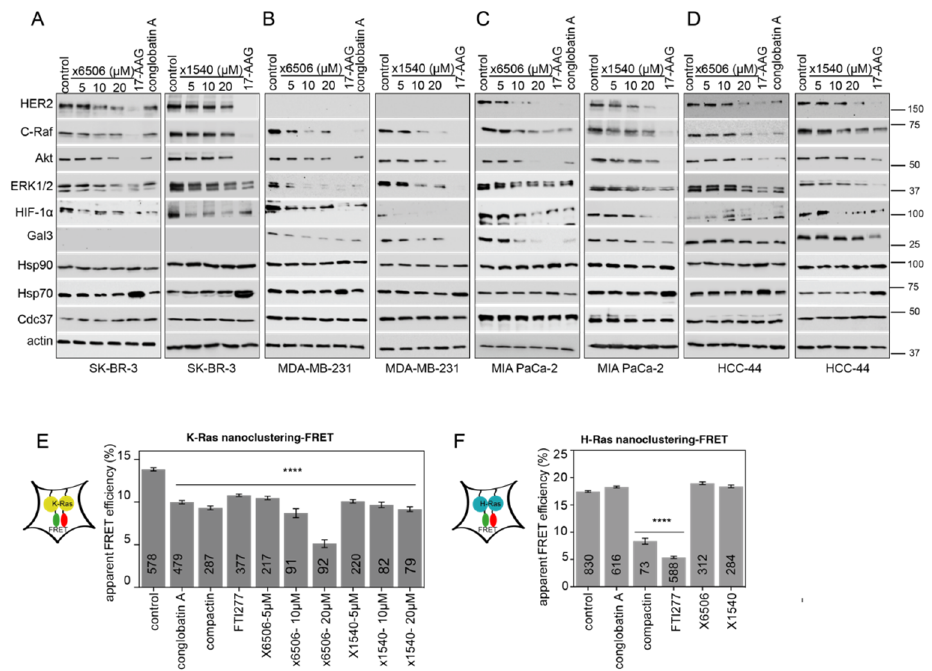
Figure 6. Top compounds decrease the expression of Hsp90 clients, and dose-dependently inhibit K-Ras nanoclustering-FRET. ( A – D ) Western blots of HER-2 overexpressing SK-BR-3 ( A ), KRAS mutant triple negative breast MDA-MB-231 ( B ), KRAS mutant pancreatic MIA PaCa-2 ( C ), and KRAS mutant lung HCC-44 ( D ) cancer cell lines. The cells were treated with 0.1% DMSO vehicle control or the indicated concentration of compounds. In total, 2 µ M 17-AAG or 10 µ M conglobatin A served as the positive control. Note the increase in Hsp90 and, in particular, Hsp70 with the 17-AAG treatment, which was not observed with interface inhibitors. All of the drug treatments were for 24 h; n = 1 independent biological repeat. ( E , F ) K-RasG12V- ( E ) and HRasG12V- ( F ) nanoclustering-FRET in HEK cells co-transfected with mGFP- and mCherry-tagged RasG12V. The cells were treated for 24 h with 0.1% DMSO vehicle control, 2 µ M conglobatin A, 2 µ M compactin, 0.5 µ M FTI277, or the indicated concentrations of × 6505 or × 1540 ( E ) or 5 µ M of these hit compounds ( F ). Compactin and FTI277 block Ras prenylation and farnesylation, respectively, and served as positive controls. The numbers in the bars indicate the number of analyzed cells; n = 3 independent biological repeats. **** p < 0.0001.